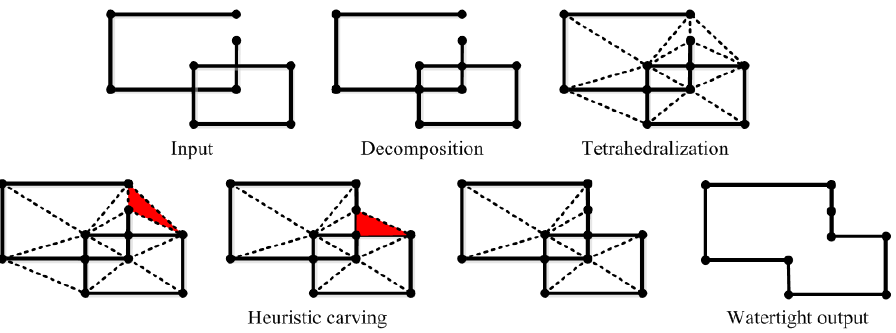
Figure 3. The 2D demonstration of the approach (in heuristic carving, a hole is filled because carving inwards the hole breaks one of the constraints)